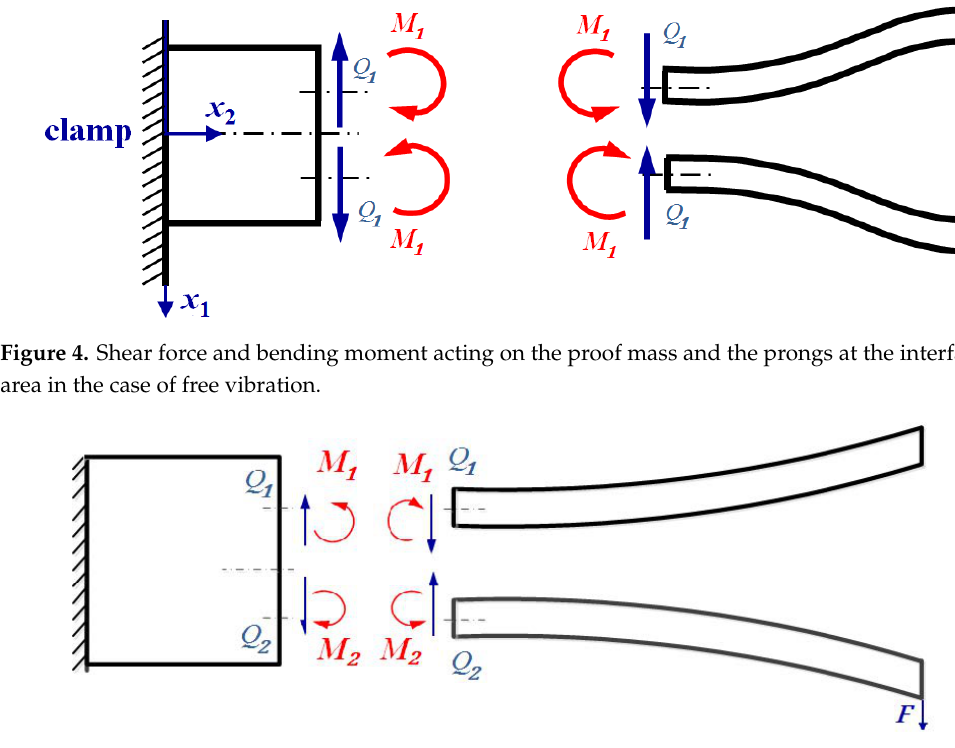
Figure 5. The shear forces and moments acting on the proof mass are exerted by the two prongs and the applied force F .